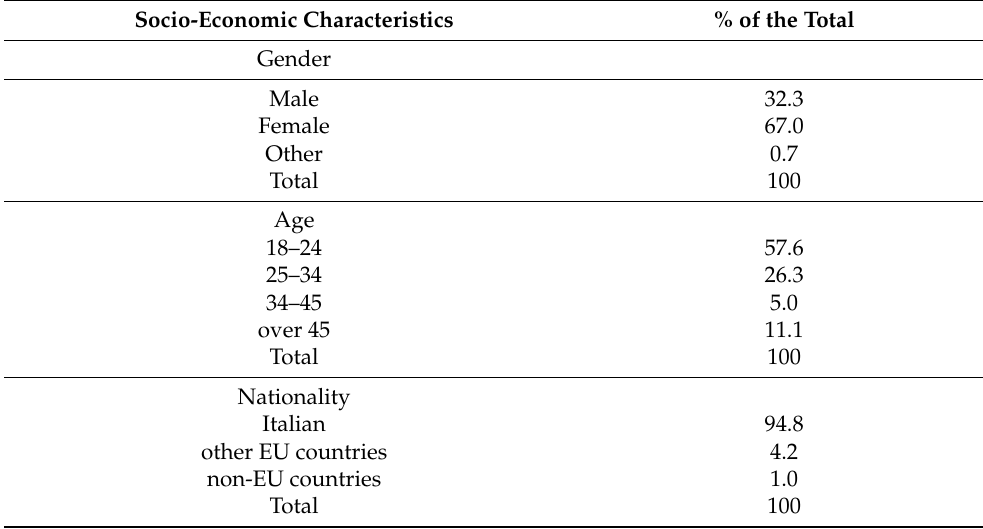
Table 2. Socio-economic characteristics of the